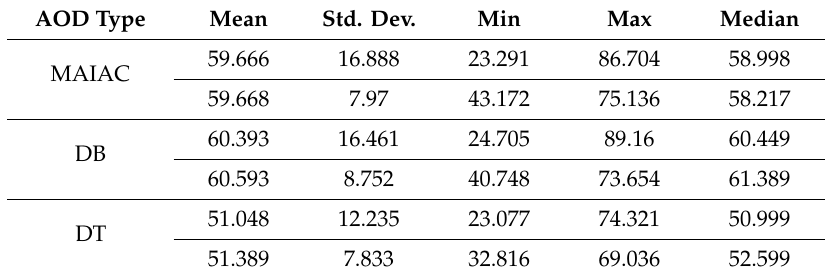
Table 4. Descriptive statistics of satellite predicted (top line) and matched ground observed